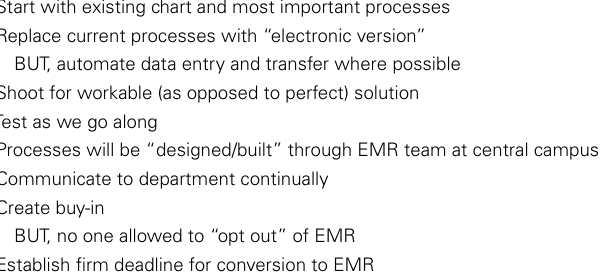
Table 3 | EMR project